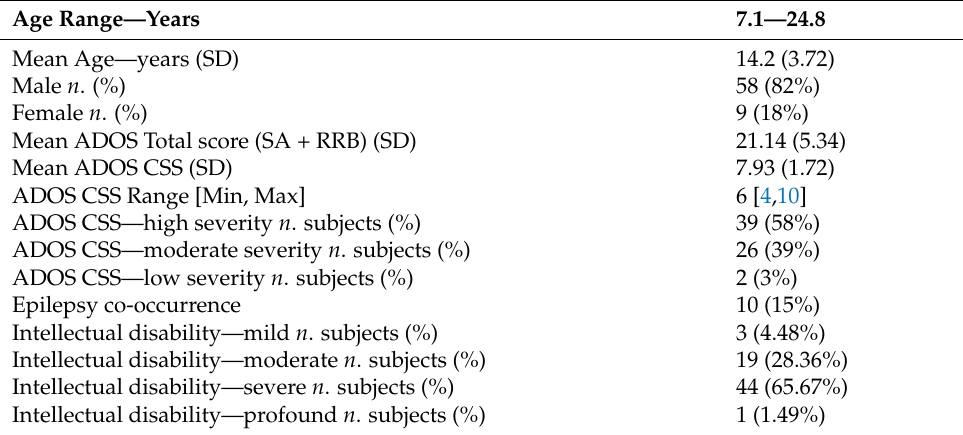
Table 1. Demographic and clinical characteristics of the ASD cohort.